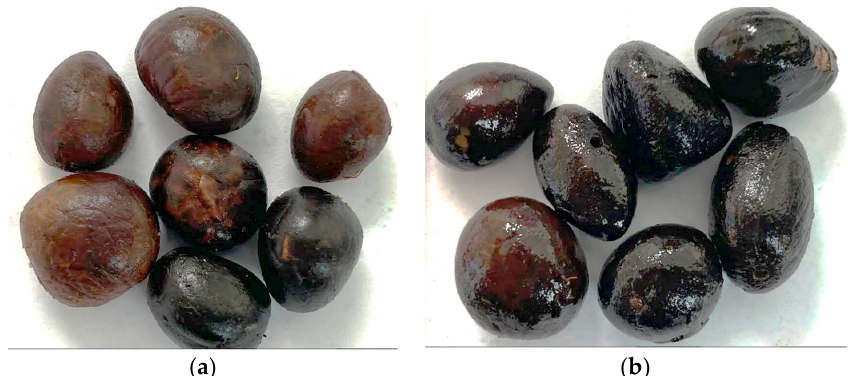
Figure 6. Picture of palm kernel before (( a ): 0.28 kg/kg) and after (( b ): 0.07 kg/kg) the drying process at 80 °C. Processes 2020 , 8 , x FOR PEER REVIEW